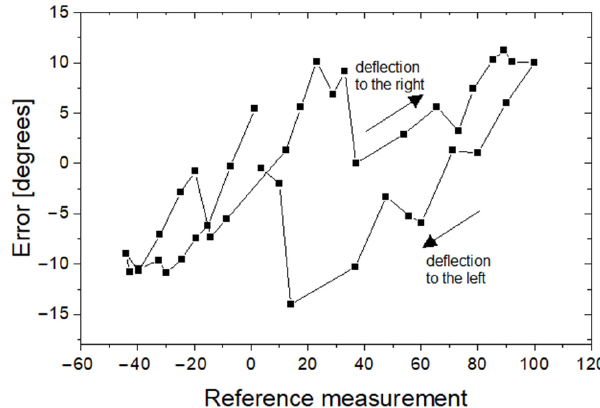
Figure 17. Hysteresis in the measuring system of the angle of deflection of the guide end.